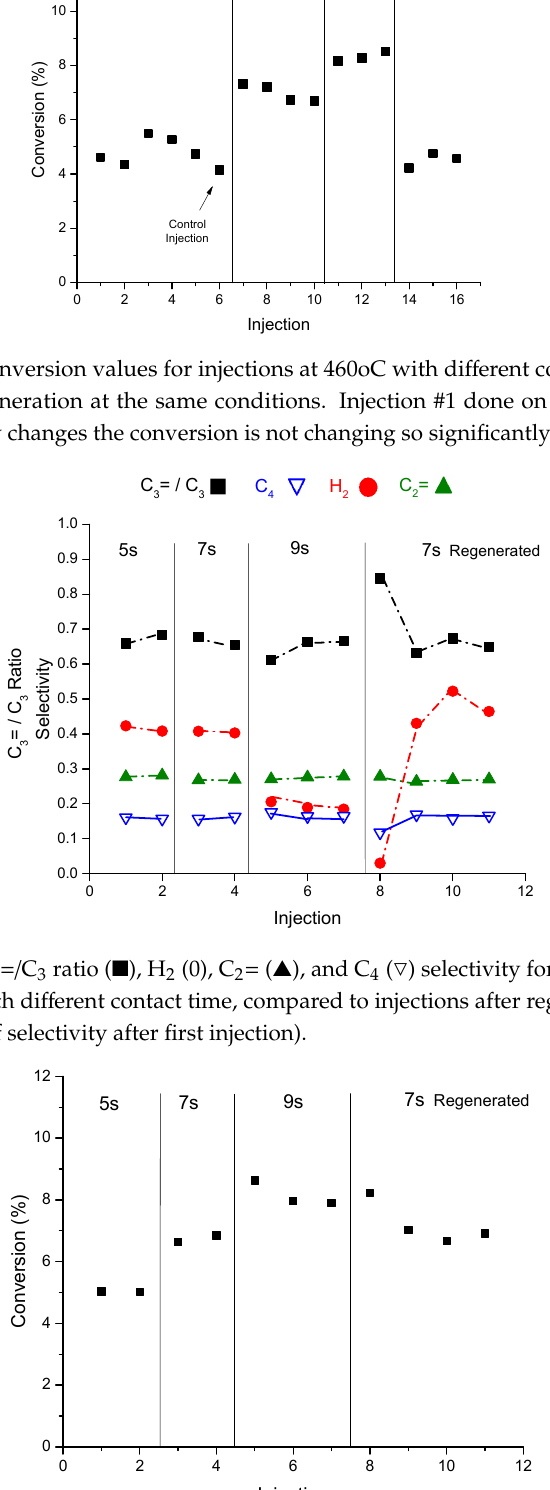
Figure A4. Detailed conversion values for injections on the riser simulator reactor at 500 °C with different contact time, compared to injections after regeneration at the same conditions. (When compared to selectivity changes the conversion is not changing so significantly).